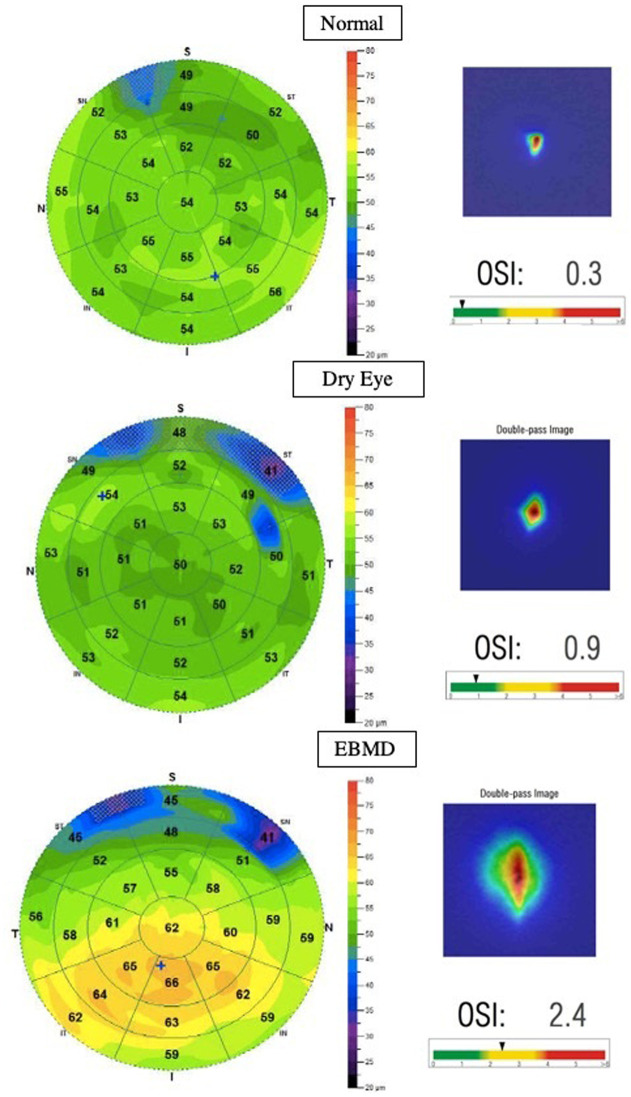
Representative corneal OCT epithelium thickness maps (left) and scatter metre analysis with the OQAS (right) of a normal patient (top), dry eye patient (middle) and an EBMD patient (bottom).